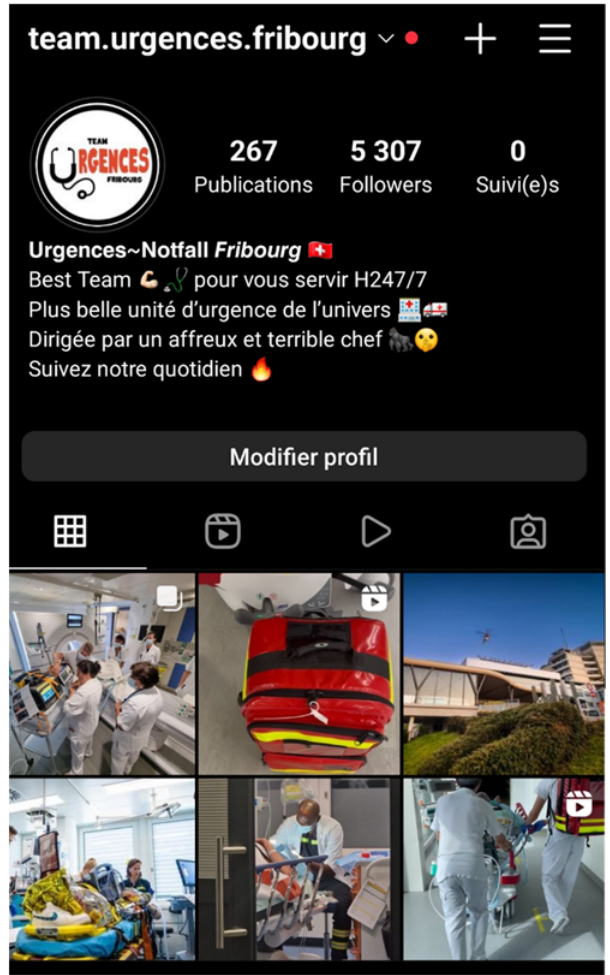
Figure 1. Smartphone screenshot of the Fribourg hospital emergency department Instagram account main menu. The account profile reads: Follow the daily life of the best team of the most beautiful emergency unit in the universe, led by an ugly and terrible boss.